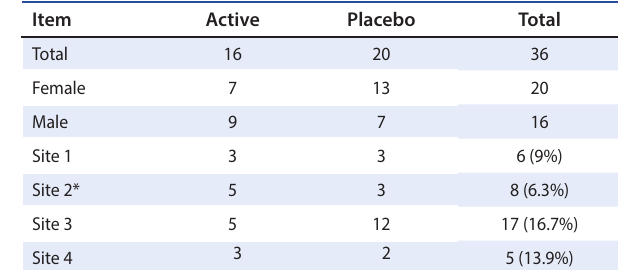
Table 3: Event summary